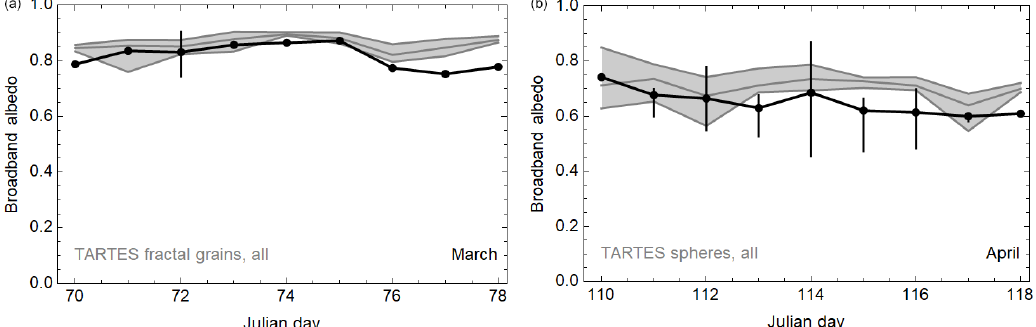
Figure 10. Evolution of measured surface albedo in Tähtelä (67.37 ◦ N, 26.63 ◦ E) on 12–19 March and 20–28 April 2009. The corresponding variation range of simulated albedo values based on simultaneous grain size and density measurements and temporally interpolated impurity content in the same day are shown in grey. The minimum, mean and maximum values are indicated with darker grey curves. The vertical error bars marked for some of the measured albedo values are based on the variation range of the measured ASD-spectra-based broadband reflectance values during the same day in the larger test area in